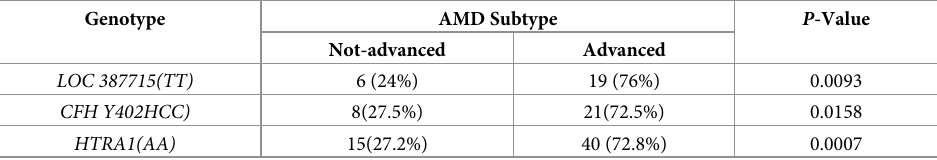
Table 3. Distribution and comparison of homozygosity of the risk allele between AMD subtypes.